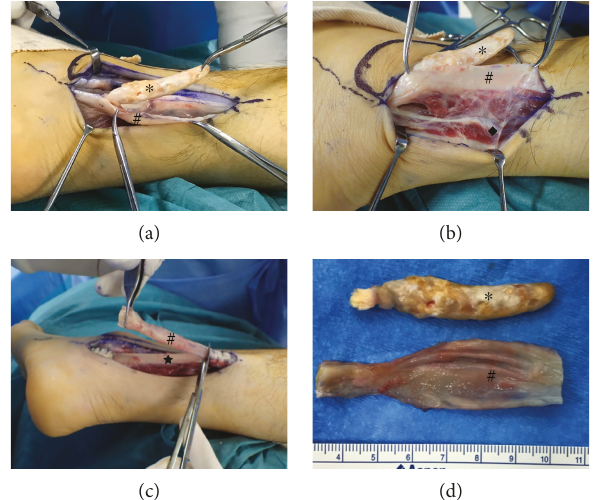
Figure 5: Resection of heterotopic ossi fi cation of the peroneus longus and peroneus quartus muscle. (a) Heterotopic ossi fi cation existed inside the peroneus longus tendon. (b) The peroneus quartus muscle running along the peroneus longus tendon was excised. (c) An end- to-side transfer of the peroneus longus tendon to the peroneus brevis tendon was performed. The degenerated part of the peroneus tendon was excised. (d) Resected heterotopic ossi fi cation and degenerated part of the peroneus longus tendon. ∗ Heterotopic ossi fi cation. # Peroneus longus tendon. ◆ Peroneus quartus muscle. ★ Peroneus brevis